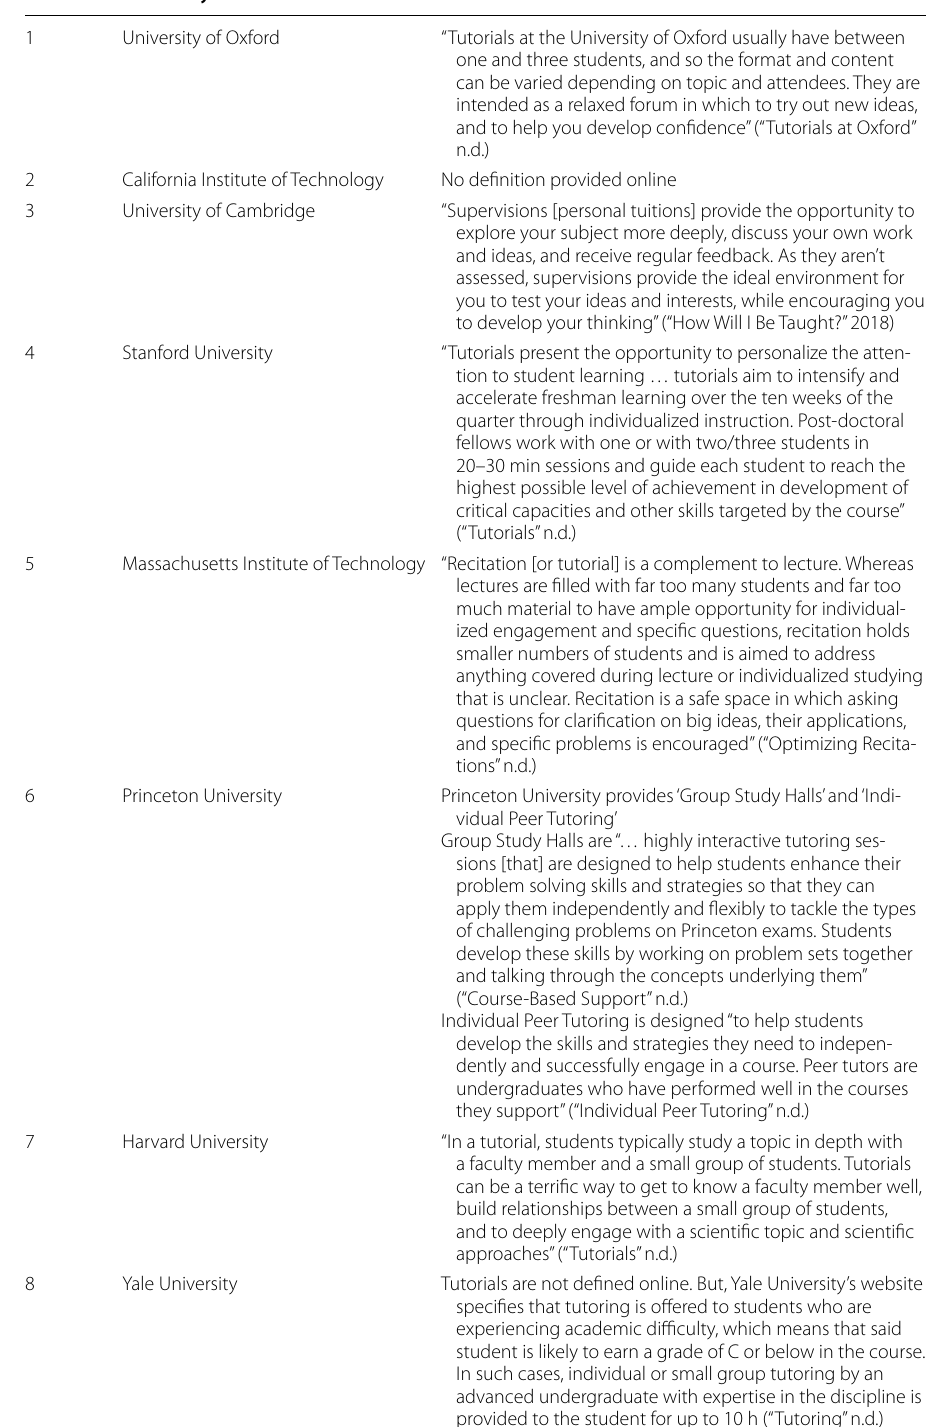
Table 1 Definitions of ‘Tutorial’ Across the Top 10 Universities as Ranked by Times Higher Education (THE) THE Rank